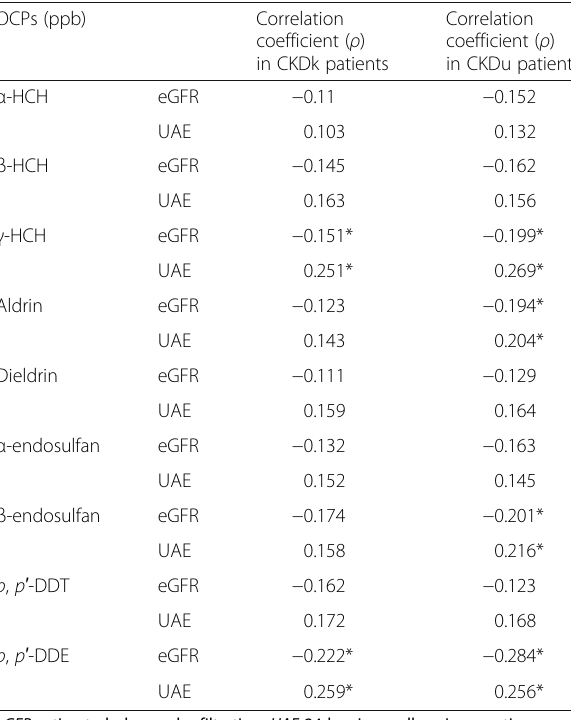
Table 3 Spearman ’ s correlation coefficient between OCP levels, eGFR, and urinary albumin excretion of CKD patients